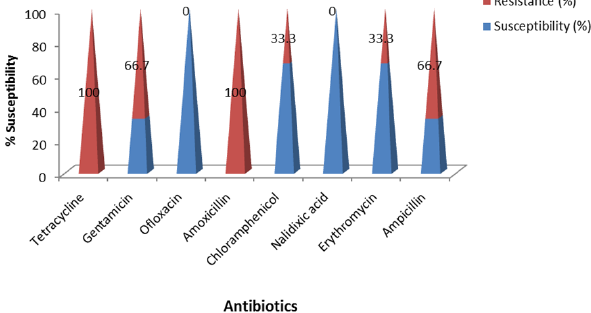
Fig. 2. Antibiogram of Salmonella typhi isolated from cow